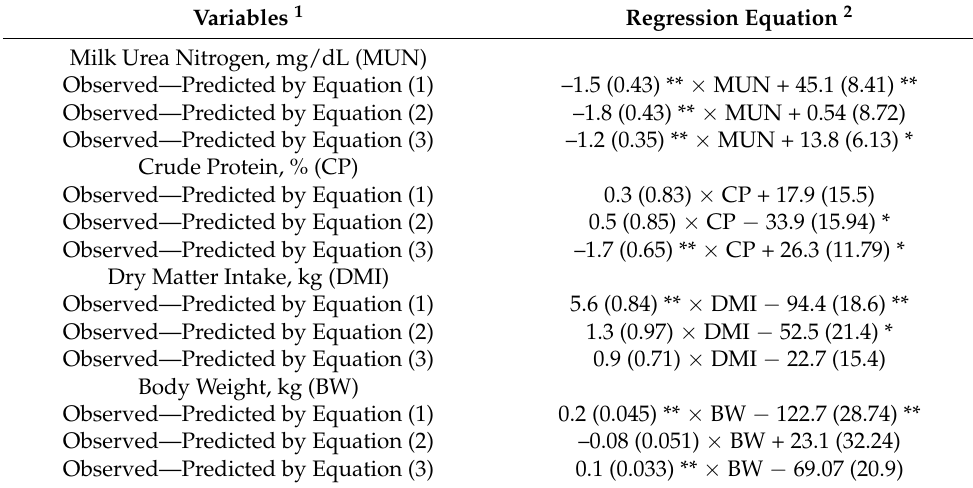
Table 3. Regression equations relating milk urea nitrogen (MUN; mg/dL), dietary crude protein content (CP; %), dry matter intake (DMI; kg), or body weight (BW; kg) to observed urinary nitrogen (UN; g/d) minus predicted UN for three established equations. A significant slope indicates that the original equation did not adequately explain variation that could be accounted for by the regressor of the current